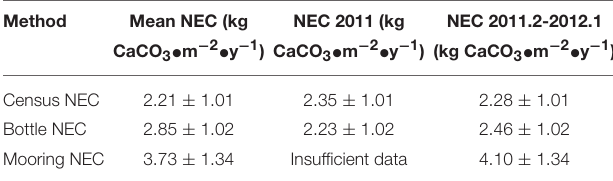
TABLE 3 | NEC summary table for each